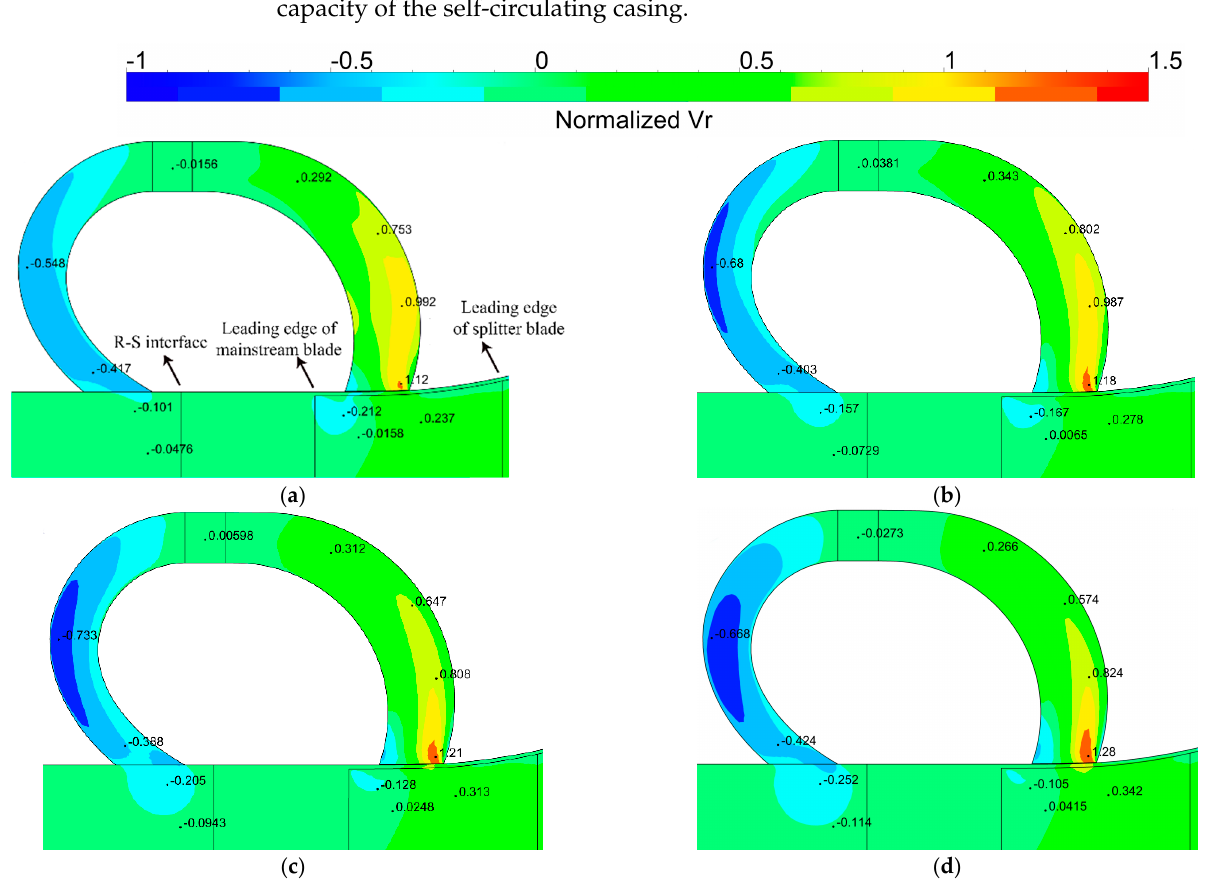
Figure 22. Contours of dimensionless radial velocity on the meridian plane. ( a ) SW. ( b ) SRCC0.36. ( c ) SRCC0.54. ( d ) SRCC0.72. ( e ) SRCC0.9. ( c ) SRCC0.54. ( d ) SRCC0.72.